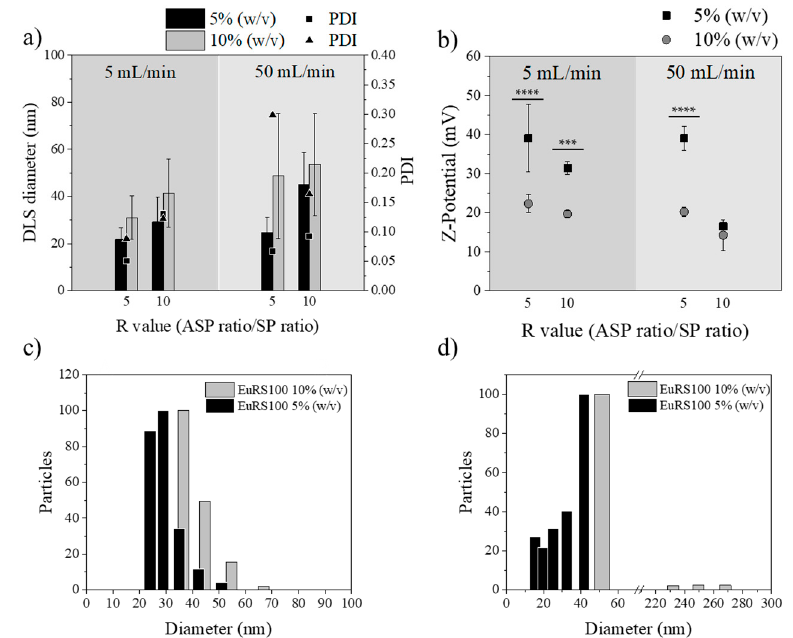
Figure 5. ( a ) DLS diameter of Eudragit ® RS100 5% (w/v) EtOH:acetone (black) and Eudragit ®